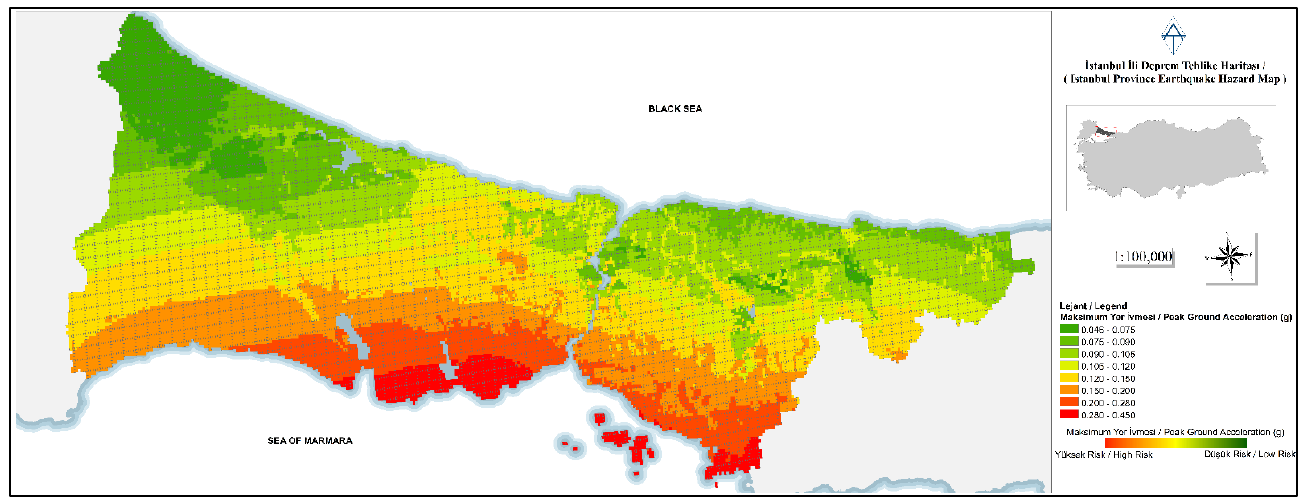
Figure 8. Istanbul Province Earthquake Hazard Map (Boore & Atkinson 2008).